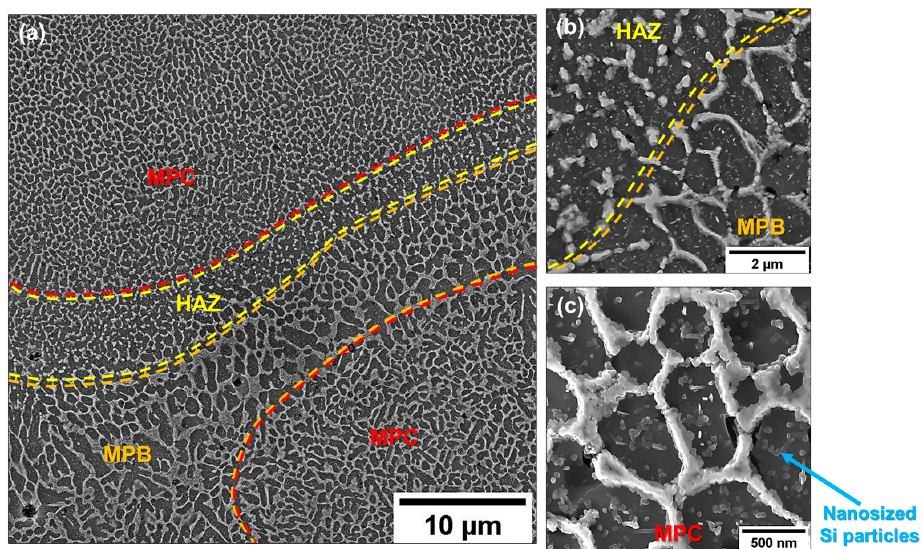
Figure 6. T5 microstructure after 2 × 10 6 cycles (about 17 h) at 200 °C observed on the transversal section of fatigue specimens. Intersection area between adjacent scan tracks ( a ). Detail of the MPB and HAZ border area ( b ) and MPC ( c ).